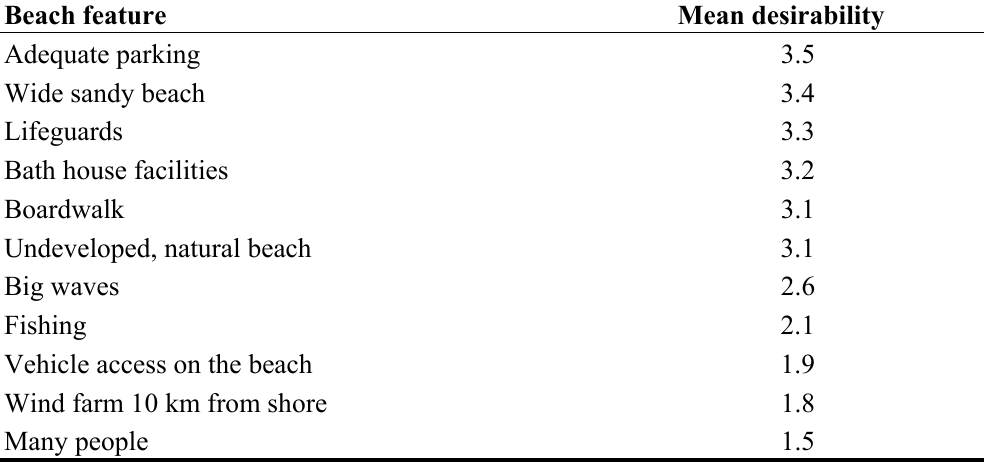
Table 3. Mean desirability of beach features (n = 953).